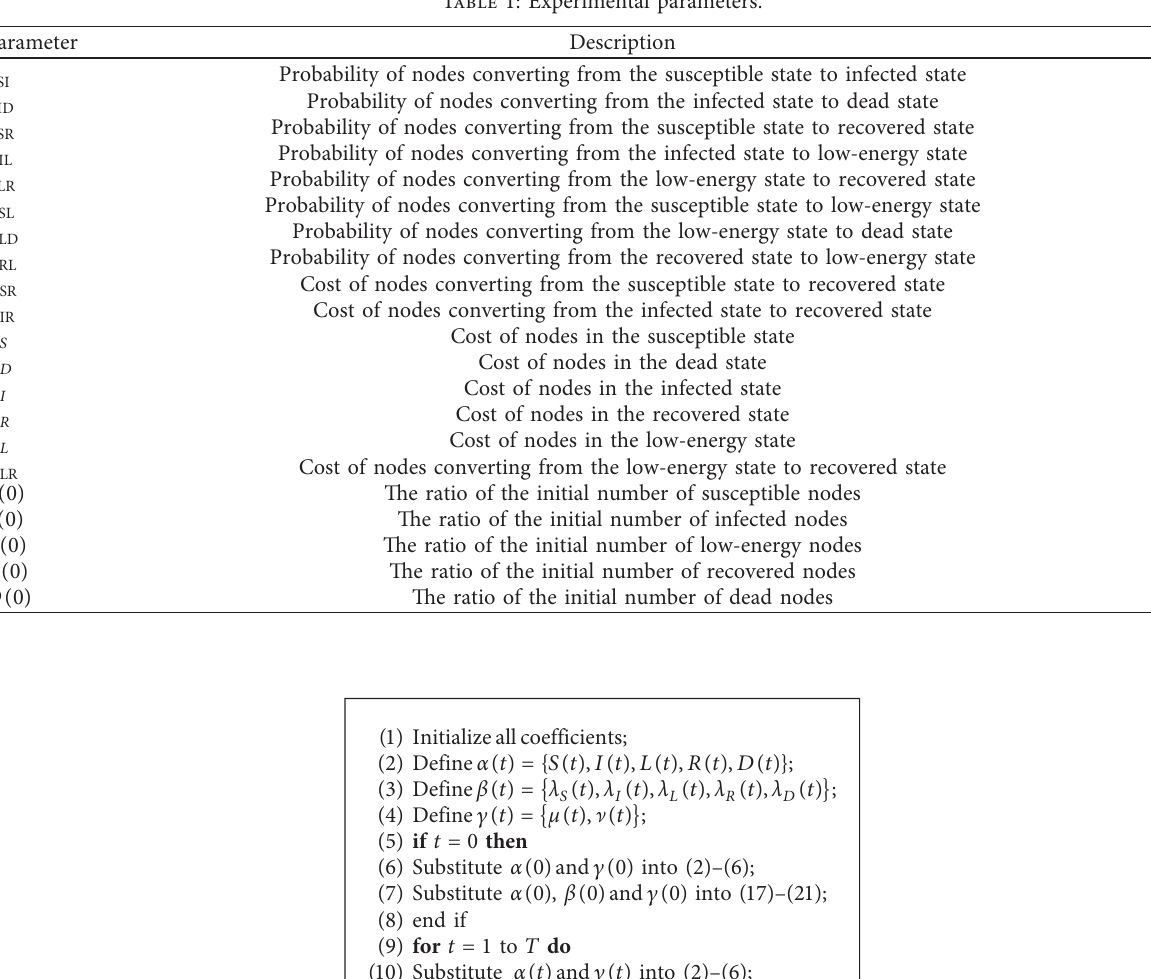
Table 1: Experimental